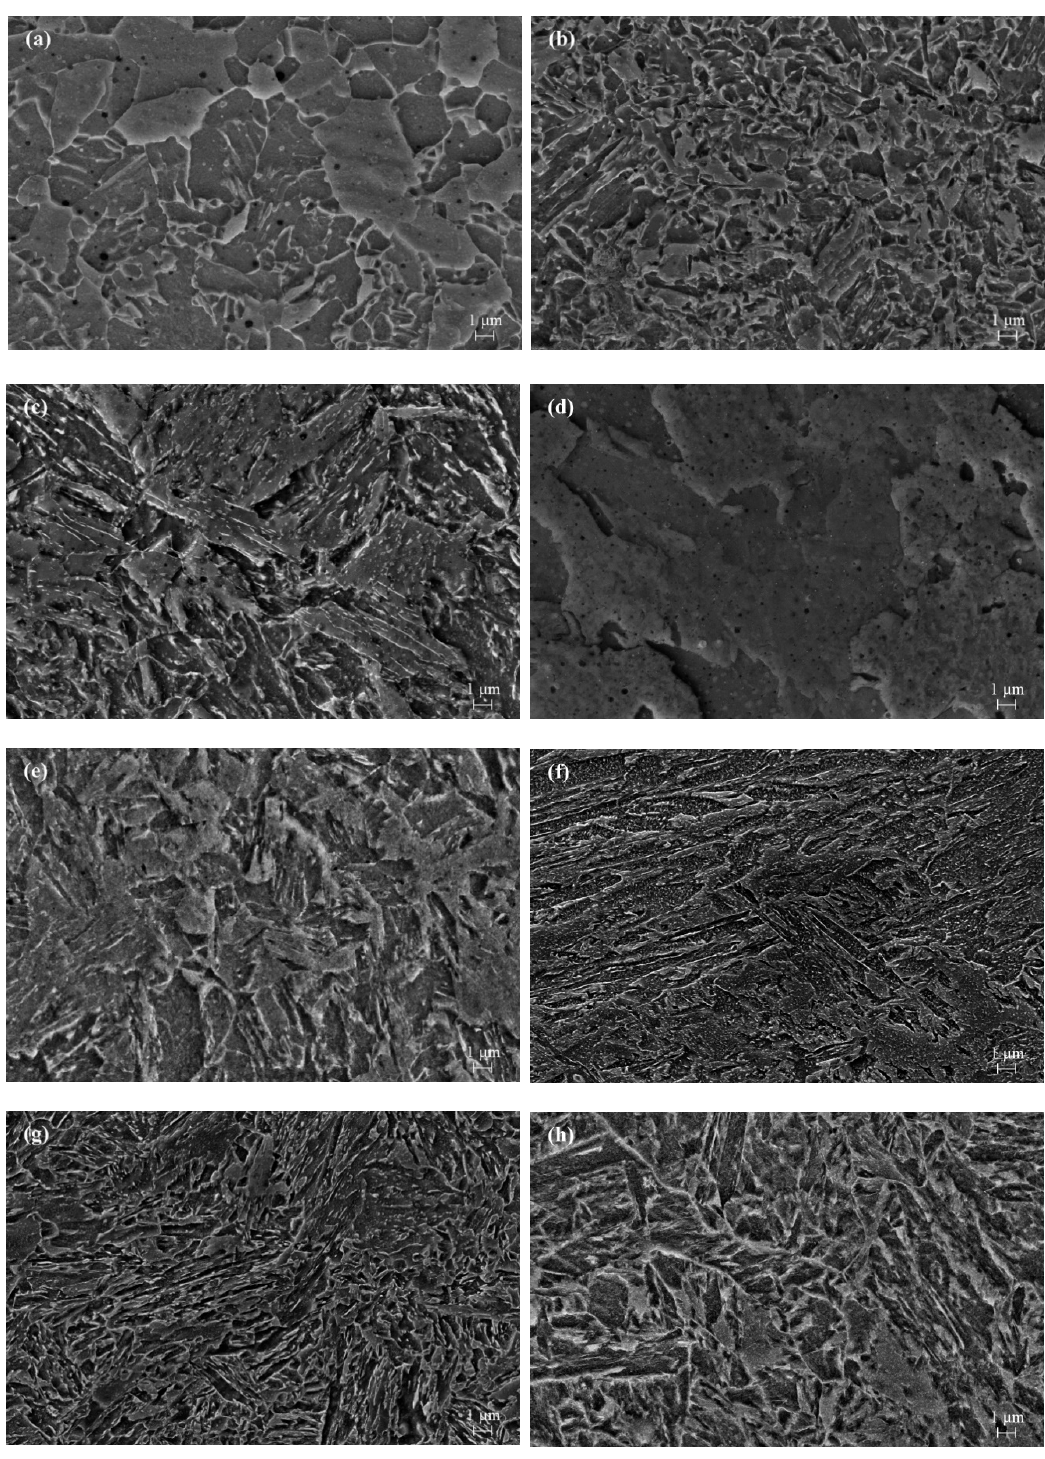
Figure 6. SEM micrographs of the as-built ( a ) W-1, ( b ) W-2, ( c ) W-3, ( d ) W-4, ( e ) WT-1, ( f ) WT-2, ( g ) G-1 and ( h ) G-2 steels.